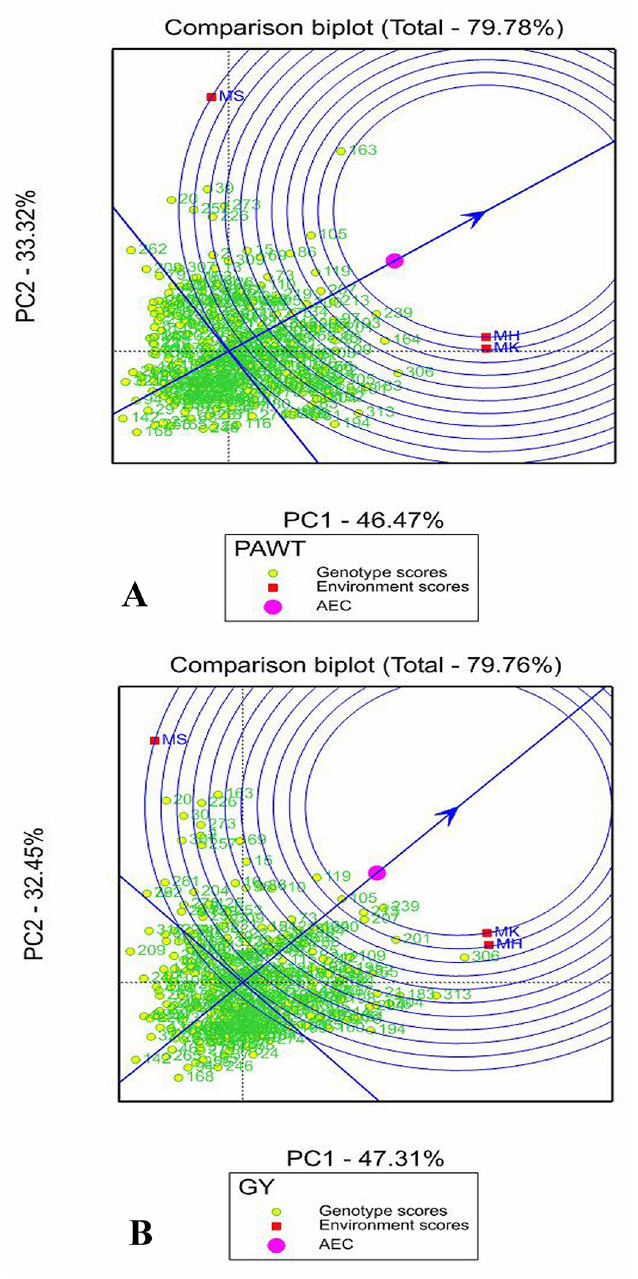
Fig 6. Environment focus scaling GGE comparison biplot of the 324 sorghum genotypes ranking the three tested environments for (A) panicle weight (PAWT) and (B) grain yield (GY). The concentric circles on the biplot show the distance of the environments from AEC and the biplot origin. The ideal environment is the one that is close to the center of the concentric circles.